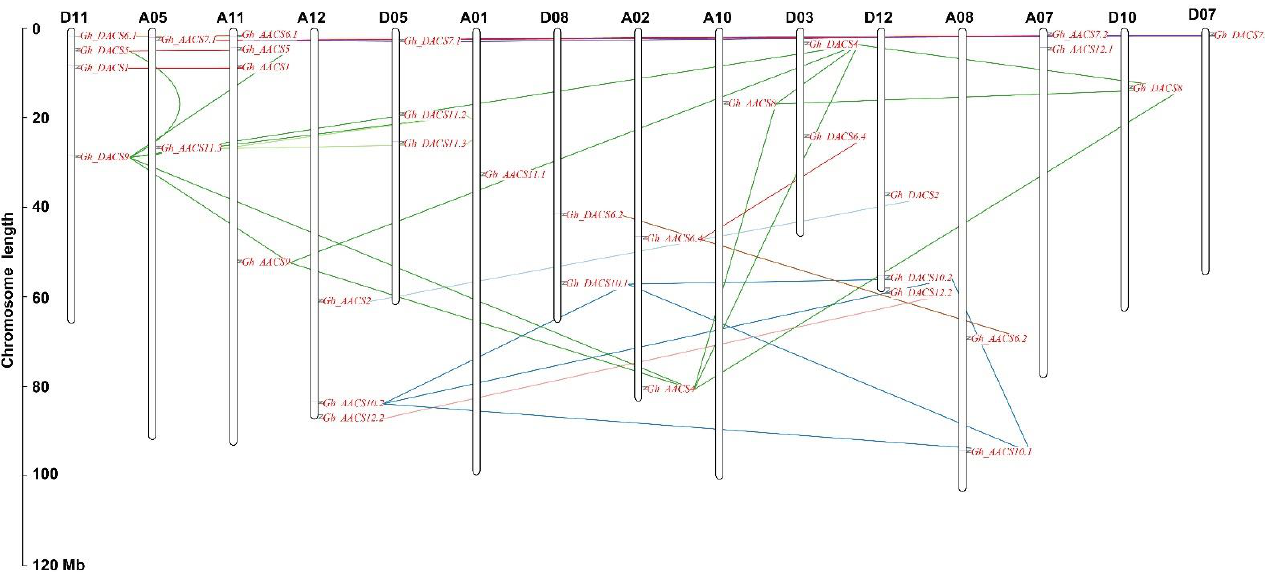
Figure 3. Chromosomal localization of the GhACS genes. Thirty-three of the 35 GhACS genes were localized to upland cotton chromosome regions; the other two, Gh_AACS6.3 and Gh_DACS6.3 , were localized to scaffolds. Lines indicate segmental duplications of the GhACS genes. Genes linked by same color line are paralogous genes pairs.